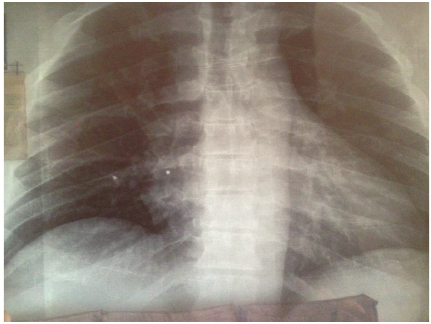
Figure 2: X-ray of the thorax. A small-sized round object of metal density (pellet) lies in the proximity of the right atrium.